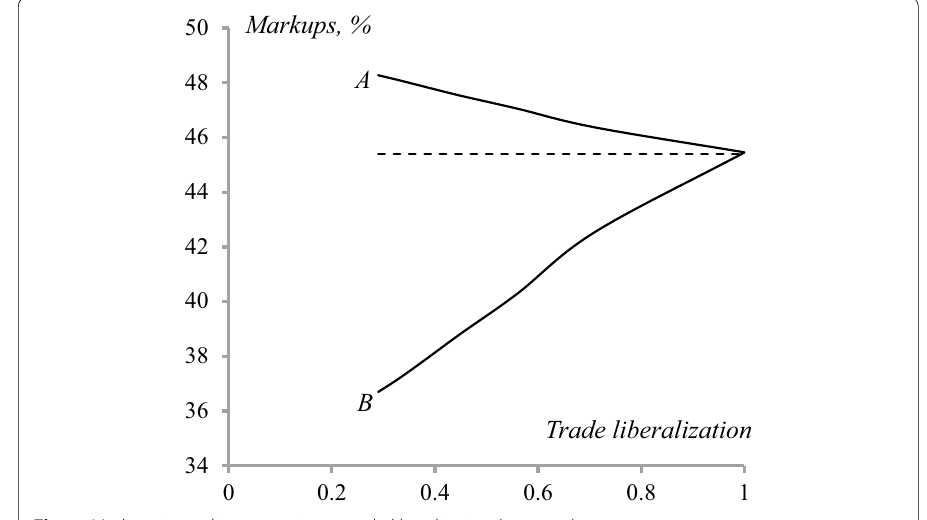
Fig. 1 Markups in trading countries vs trade liberalization ( σ A < σ B )